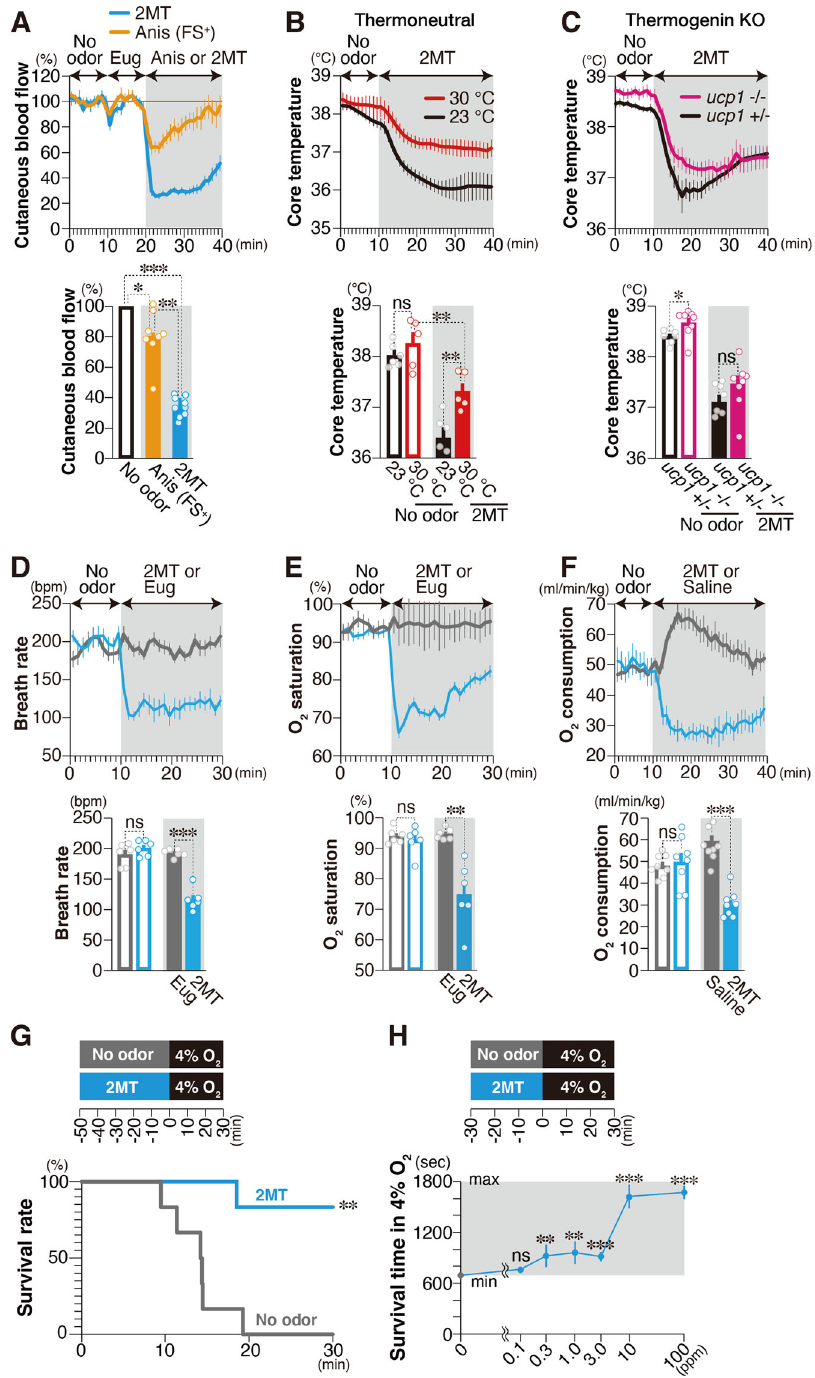
Fig. 2 Innate fear stimuli suppress basal metabolism to confer anti-hypoxia. A Temporal analyses of cutaneous blood fl ow in response to 2MT and Anis (FS + ) are shown [ n = 9 for 2MT and n = 8 for Anis (FS + ); upper panel]. The mean cutaneous blood fl ow in the no-odor (black), Anis-FS + (orange), and 2MT (blue) conditions are also shown (lower panel). Levels in no-odor condition were set at 100%. B , C Temporal analyses (upper panels) and mean values (lower panels) for core body temperature induced by 2MT under ambient (black) and thermoneutral (red) conditions ( B ; n = 6 for control condition and n = 5 for thermoneutral condition), and in control (black) and ucp1 − / − (red) mice ( C ; n = 7 for control and n = 8 for ucp1 − / − ). D , E Temporal analyses of respiratory rate ( D ) and oxygen saturation ( E ) in response to eugenol (gray), a neutral odor, and 2MT (blue) ( n = 6 each). Mean respiratory rate ( D ) and oxygen saturation ( E ) in response to no odor (open bars), eugenol (solid gray bars), and 2MT (solid blue bars) are also shown (lower panels). F Temporal analyses of oxygen consumption in response to saline (gray) and 2MT (blue) ( n = 8 each). Mean oxygen consumption in response to no odor (open bars), saline (solid gray bars), and 2MT (solid red bars) are also shown (lower panel). G The experimental procedure (top), and survival rate in 4% oxygen with (blue; n = 6) and without (gray; n = 6) prior presentation of 2MT. H Survival time in 4% oxygen with 30min prior presentation of indicated concentration of 2MT gas ( n = 5 for 100 p.p.m., n = 6 for other concentrations and n = 34 for control). Data are means±SEM. Student ’ s t test, two-way ANOVA followed by Tukey ’ s multiple comparison or Student ’ s t test followed by Bonferroni correction was performed. For comparison of survival curve, log-rank test was performed. * P <0.05; ** p <0.01; *** p <0.001; n.s., p >0.05. COMMUNICATIONS BIOLOGY| (2021) 4:101 |https://doi.org/10.1038/s42003-020-01629-2|www.nature.com/commsbio